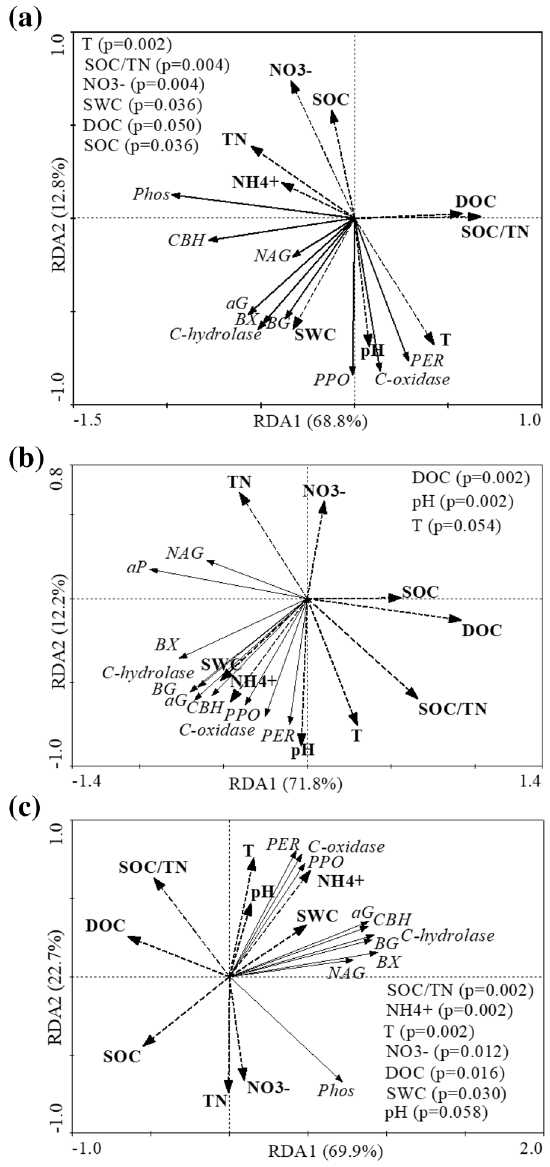
Figure 3. Redundancy analysis (RDA) between carbon (C)-, nitrogen (N)- and phosphorus (P)-hydrolase and oxidase activities and soil physico-chemical properties determined for long-term N fertilization (N, a ), warming (W, b ) and WN interaction ( c ). Listed variables of soil physico-chemical properties were significantly correlated with the first RDA axis ( p < 0.05). The abbreviations are the same as in Table 3 and Fig. 2.